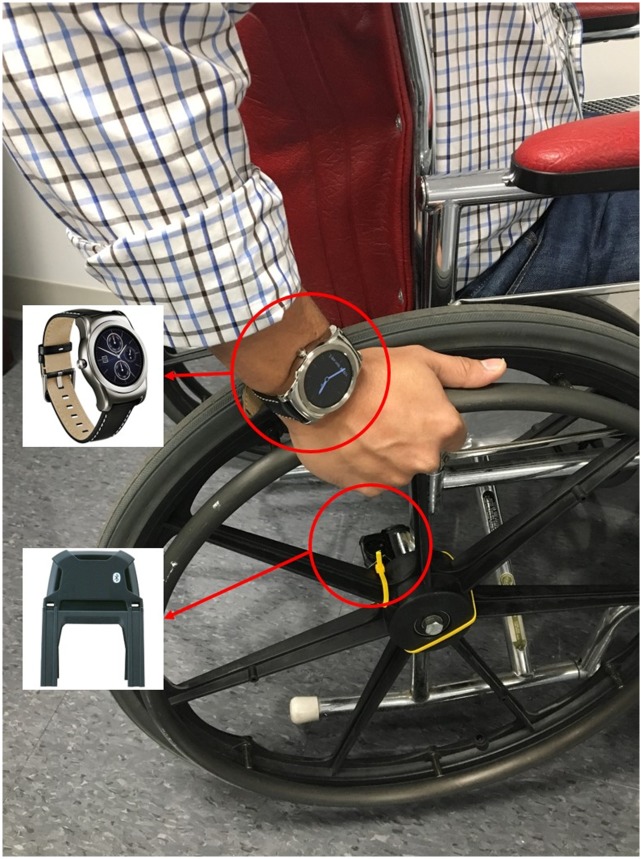
A participant using the JITAI sensors to measure and motivate PA.